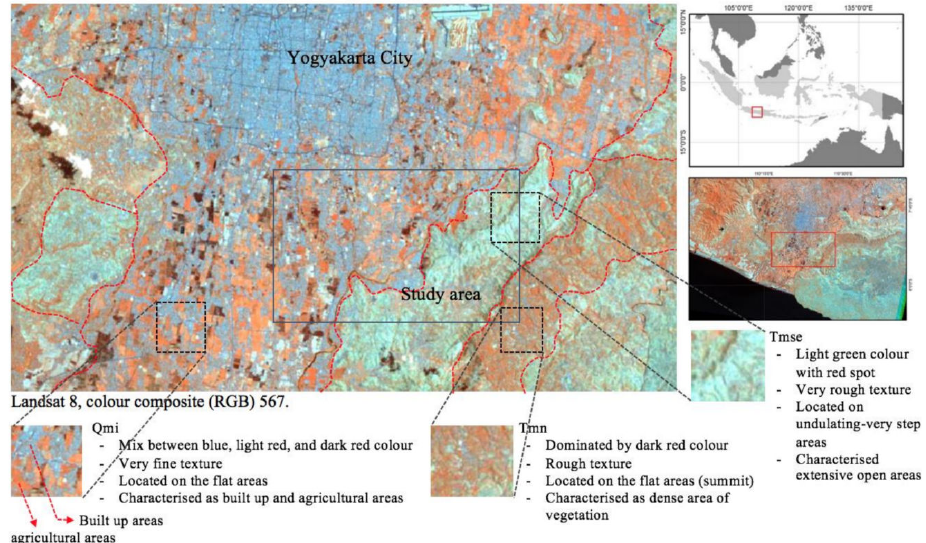
Figure 9. The lithological characteristics based on the Landsat 8 image, colour composite (RGB) 567.